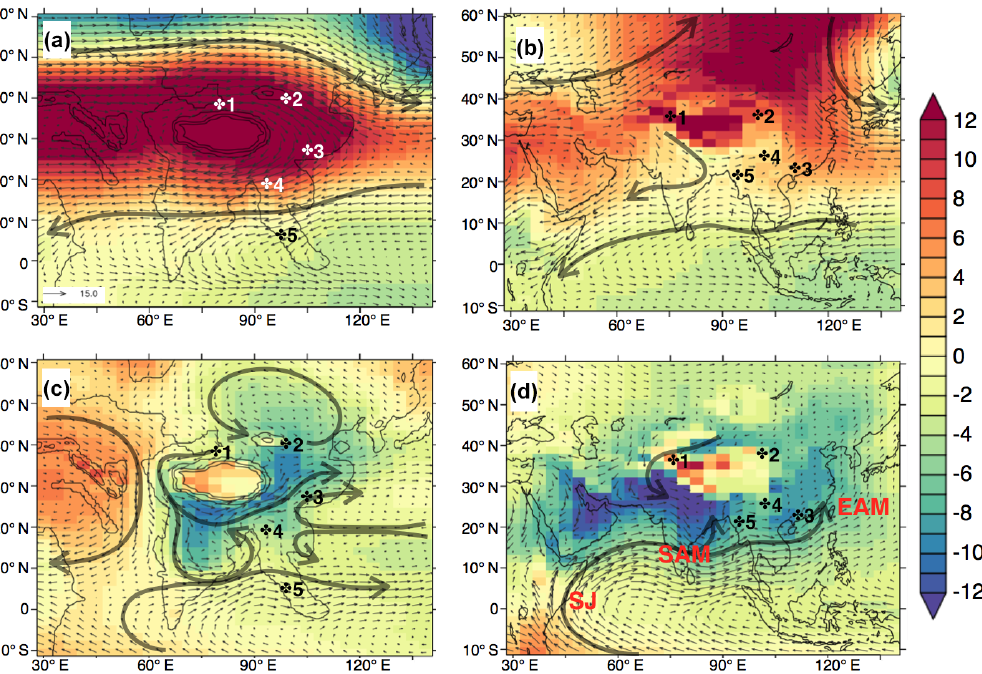
Figure 4. Sea level pressure anomaly (shading, in millibars) and 850mbar wind patterns (vectors, ms − 1 ) obtained in EOC4X (a, c) and compared to control simulation results (b, c) . (a, b) Winter circulation pattern; (c, d) summer circulation patterns. Main wind patterns are represented by a thick black arrow, and low-pressure zones (high pressure) are marked by letter L (H). Numbers corresponds to regions highlighted in the main text: 1: Tarim sea region (Bougeois et al., 2018), 2: Xining Basin (Meijer et al., 2019; Licht et al., 2014a), 3: Maoming Basin (Herman et al., 2017; Spicer et al., 2016, 2017), 4: Jiuchuan Basin (Sorrel et al., 2017) and 5: Pondaung Formation in Myanmar (Licht et al., 2014b).